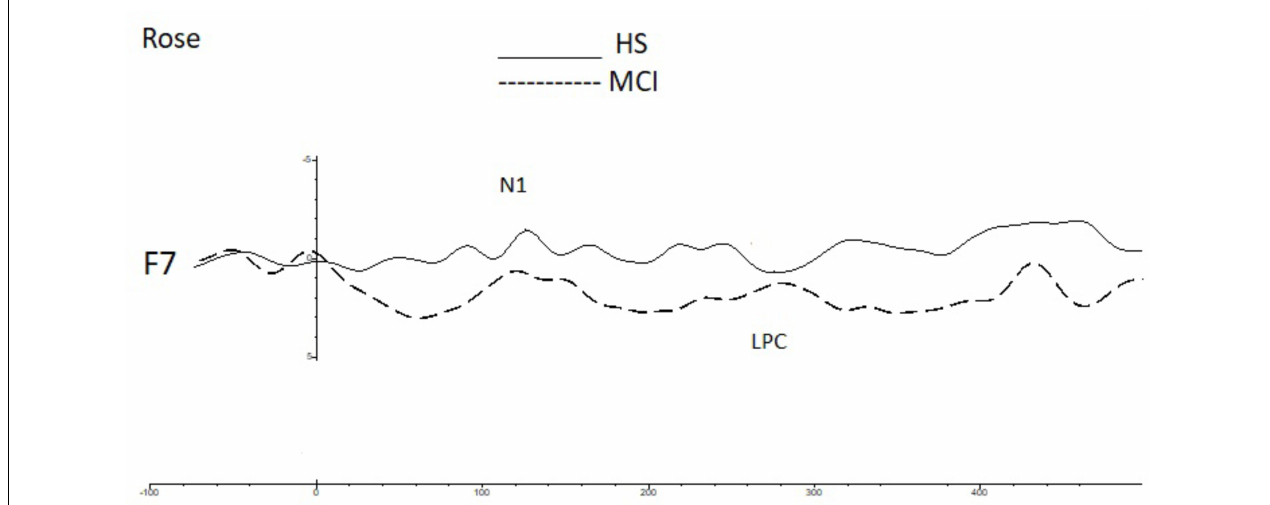
FIGURE 2 | A comparison of the grand averages of OERP waveforms (recorded at the F7 electrode) elicited by the rose odorant for the MCI (dashed line) and HS (continuous line) groups. The N1 and LPC components are labeled. TABLE 2 | Means of N1 and LPC amplitudes ( µ V) elicited by the rose odorant for MCI and HS groups. Electrode N1 Rose LPC Rose